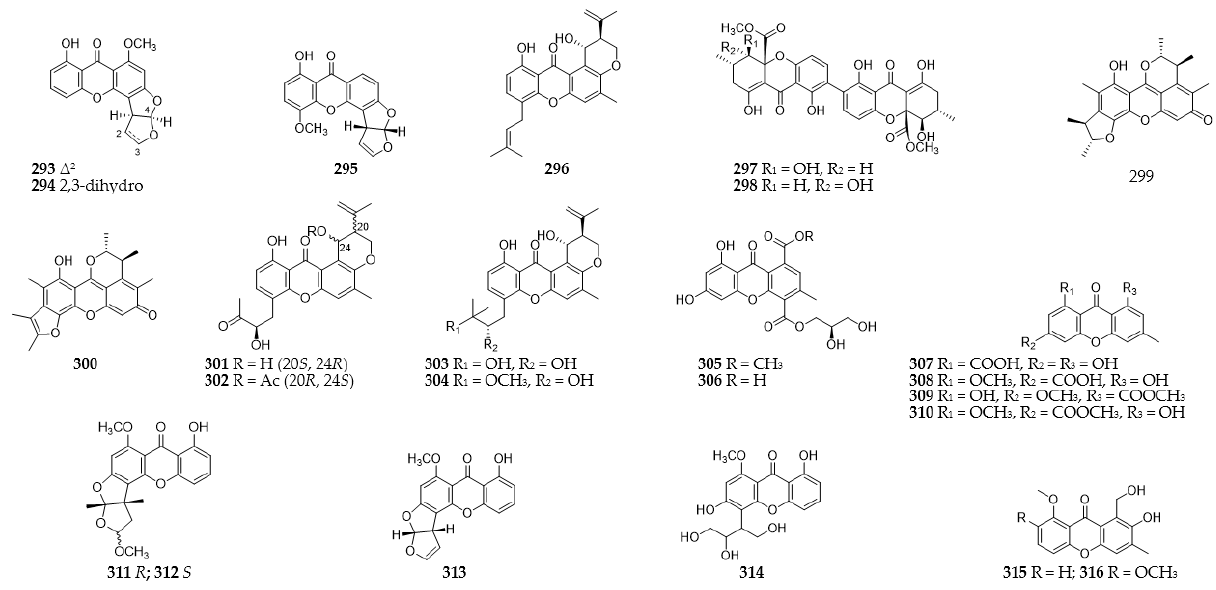
Figure 19. Aspergillus -derived xanthones ( 293 – 316 ).